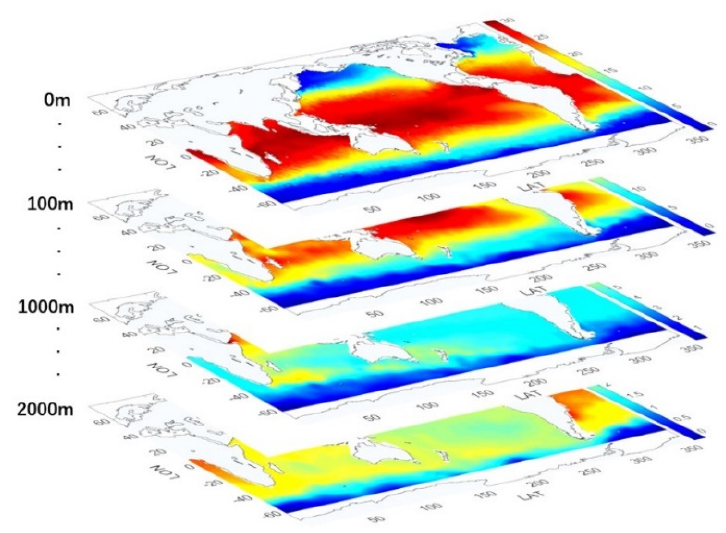
Figure 1. Technical flowchart for satellite-based time series reconstruction of global subsurface temperature based on the ConvLSTM model.